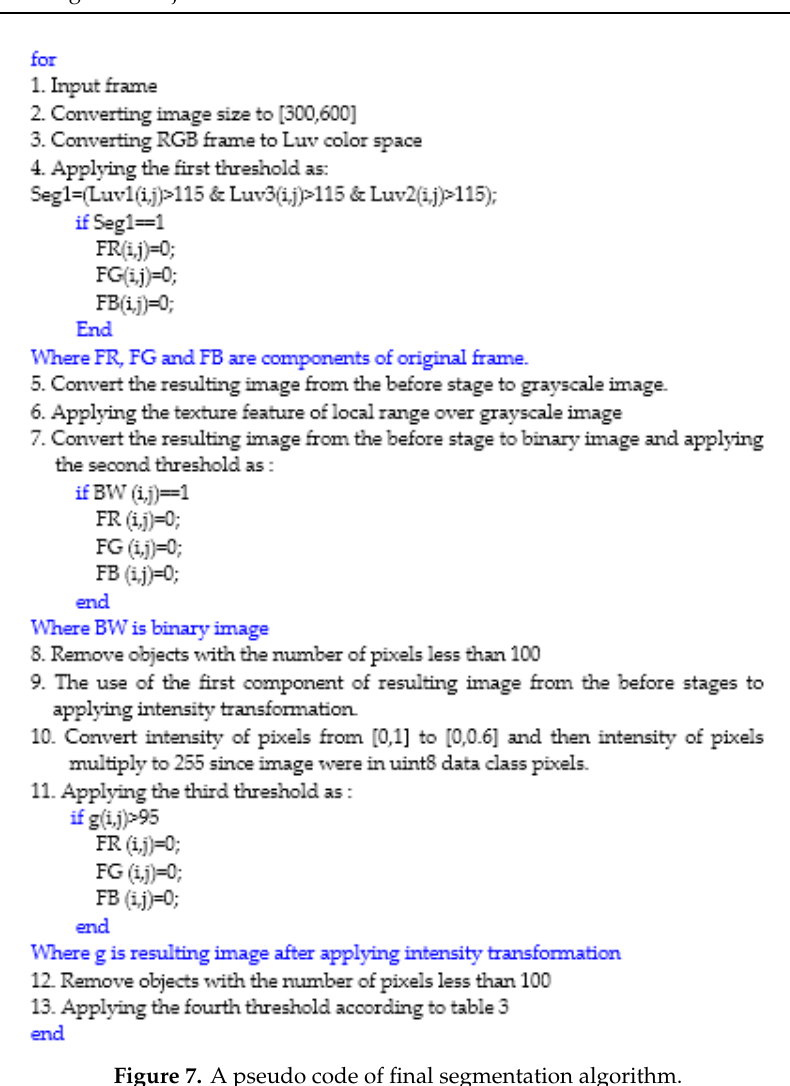
Figure 7. A pseudo code of final segmentation algorithm.